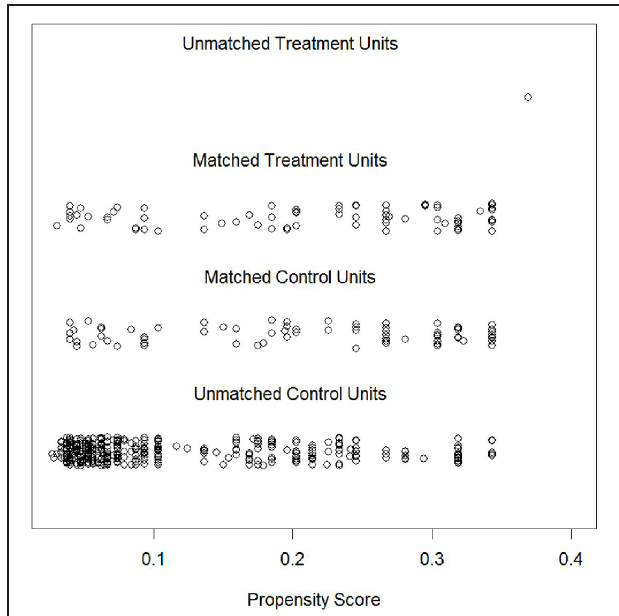
FIGURE 2 | Distributions of propensity scores for the unmatched and matched gifted (“Treatment”) and non-gifted (“Control”) groups.